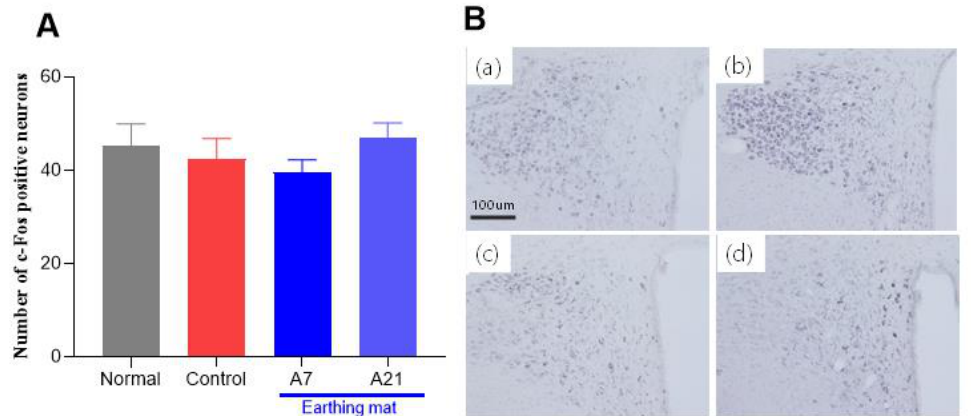
Figure 6. ( A ) Effect of earthing mat on c-Fos expression, Data represent means ± SEM. ( B ) Photo- graphs showing the distribution of CRF immunoreactive cells in the PVN of the ( a ) Normal group, ( b ) Control group, ( c ) A7 group, ( d ) A21 group. Coronal sections were 30 µ m thick, and the scale bar represents 100 µ m.